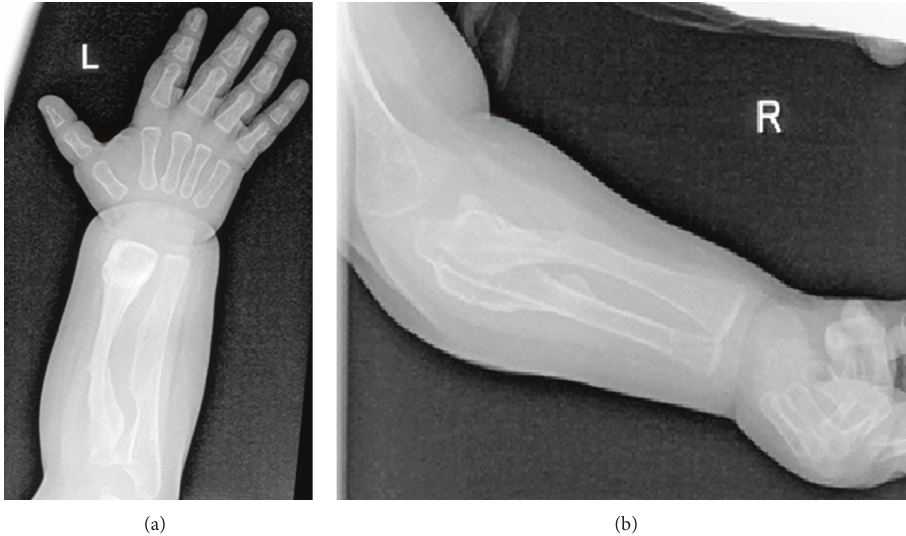
anterior subluxation of the radial heads; the ends of the long bones were thick. Osteoporosis and broad and short bones of the hands and the carpal bones were small and dysplastic associated with apparent swelling of the forearms.